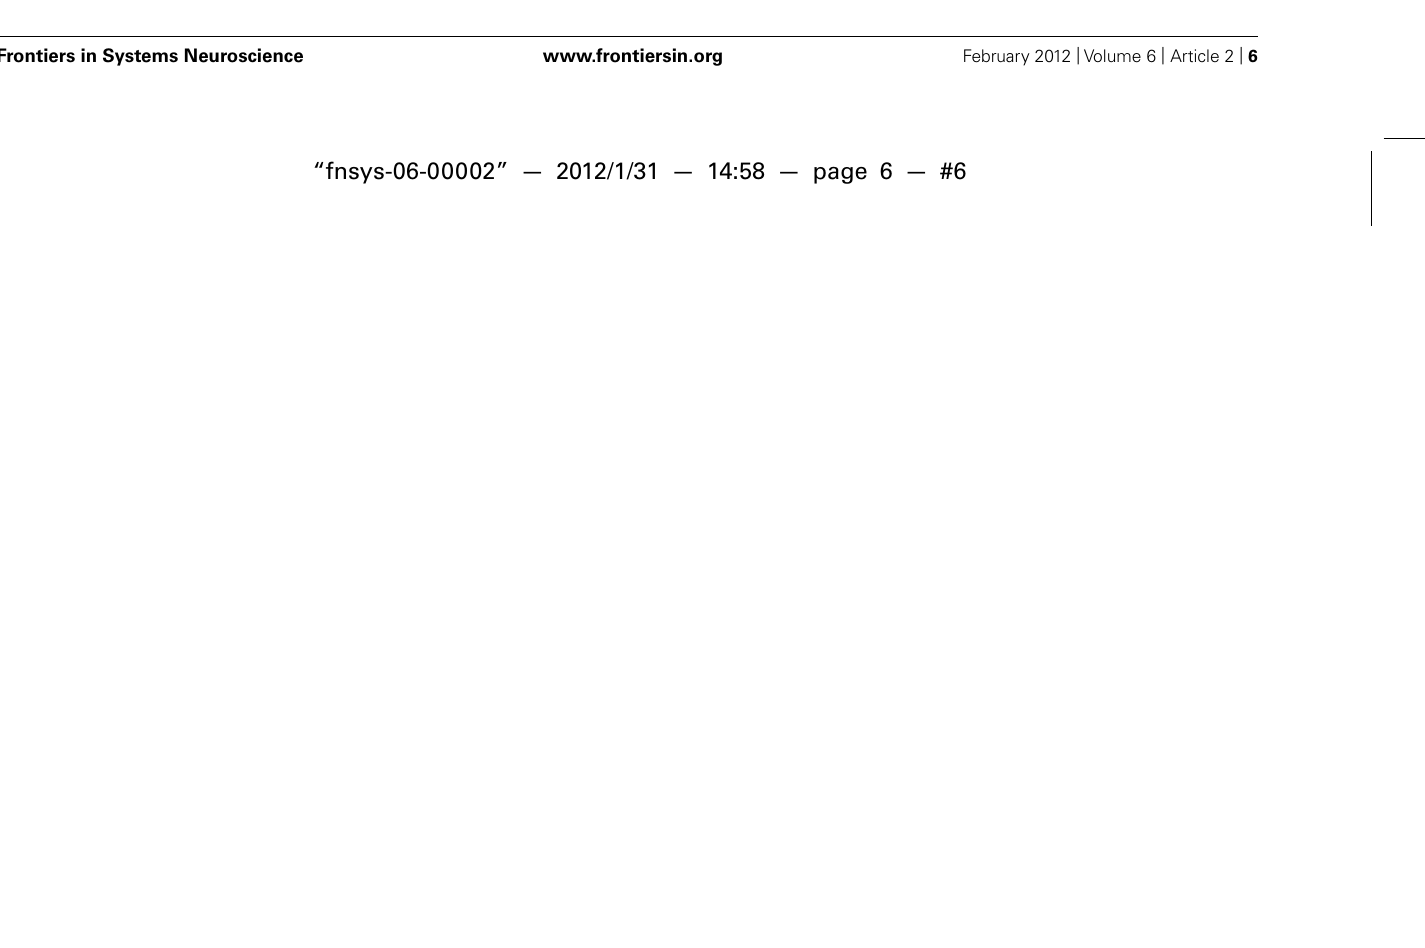
FIGURE 2 | (A) Overall activation to all sound stimuli in the controls and patients combined (thresholded at p < 0.05, FWE-corrected, and minimum cluster size of 100 voxels) occurred in the bilateral auditory cortices. Below the glass brain display, the bar plot shows the activation to various frequencies (interpolated to 40 dB HL) for both subject groups separately.